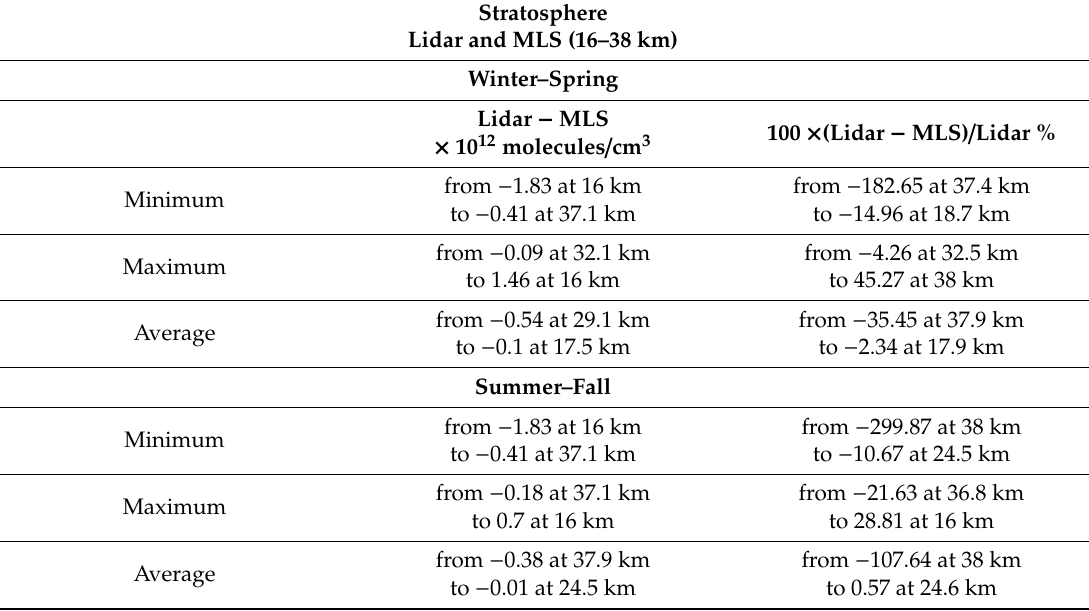
Table 4. Comparison of lidar and Aura satellite data for two seasons: winter-spring and